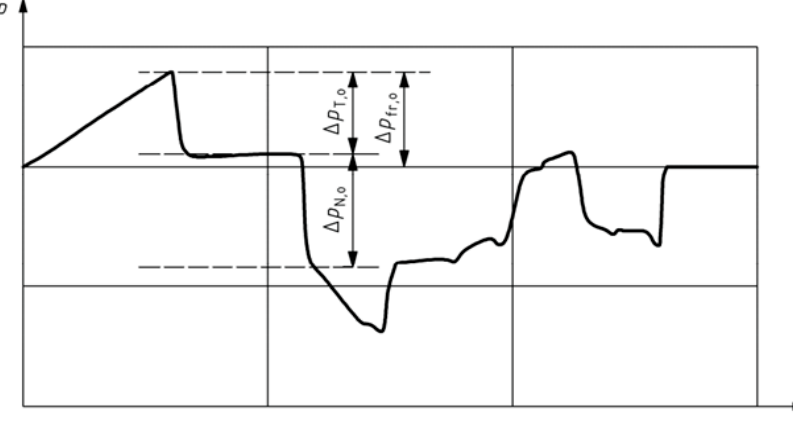
Figure 2. Tunnel pressure profile at a position just behind the nose of a train.